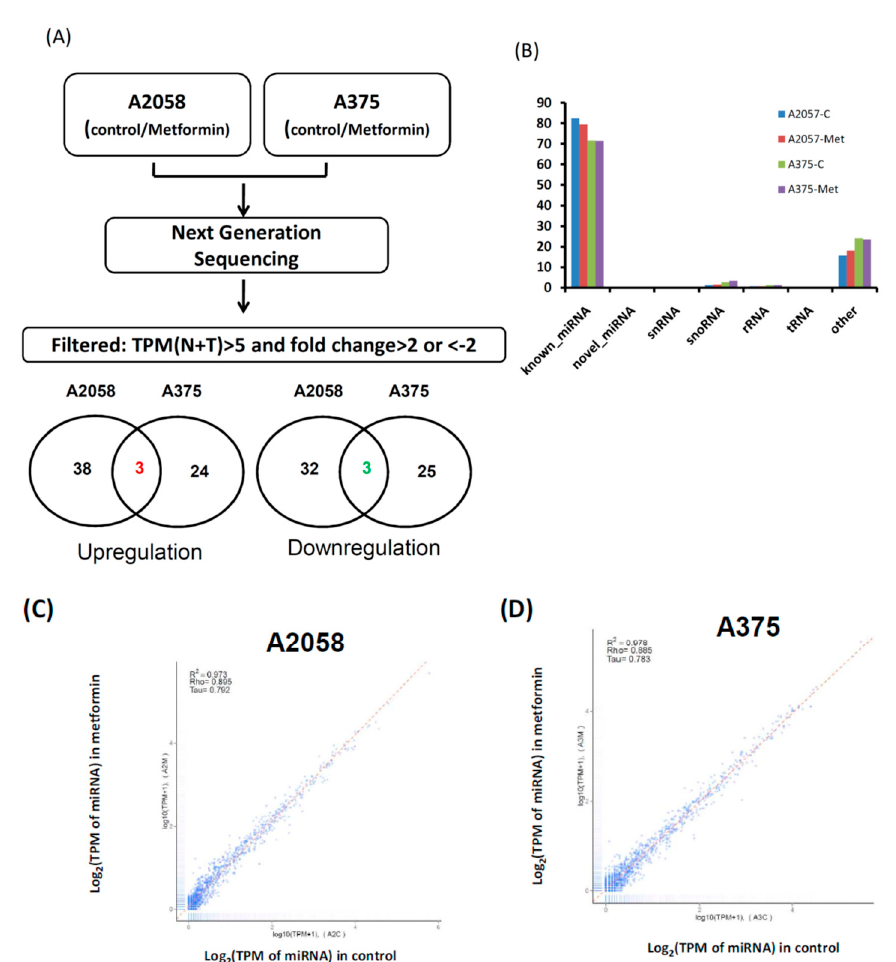
Figure 3. Flowchart of process to identify metformin-regulated miRNA candidates in melanoma cells through next generation sequences (NGS). ( A ) Small profiles of A2058 and A375 cells treated with or without metformin were analyzed using NGS. Comparison of the miRNA expression profiles between the control and metformin treatment samples and filtering steps are as follows: (1) fold change ≥ 2 or ≤ 2 and (2) sums of Transcript per million (TPM) in control and treatment groups ≥ 5. Venn diagrams depict the number of upregulated and downregulated miRNA candidates in A2058 and A375 cells treated with or without metformin. ( B ) Categories of sequence reads in four libraries were detected after mapping the human database. ( C ) Scatter plot of miRNA distribution in A2058; metformin treatment ( Y -axis) vs. control group ( X -axis); ( D ) scatter plot of miRNA distribution in A375; metformin treatment ( Y -axis) vs. control group ( X -axis).